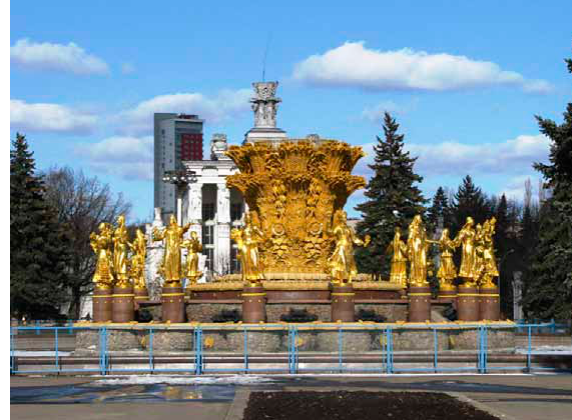
fig. 24. The fountain of “The friendship of nations” in the complex of the exhibition of the accomplishments of the all-union economy. Moscow, russia. T. Korobova